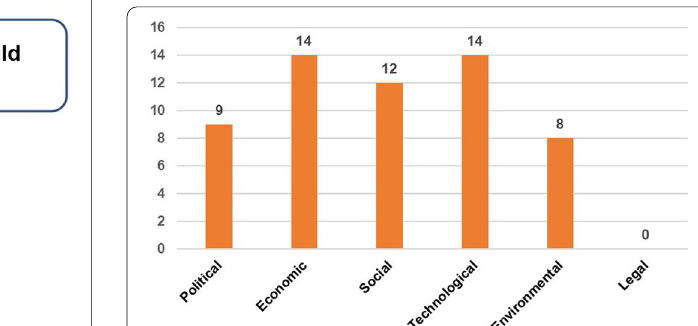
Fig. 3 Number of wild cards per PESTEL